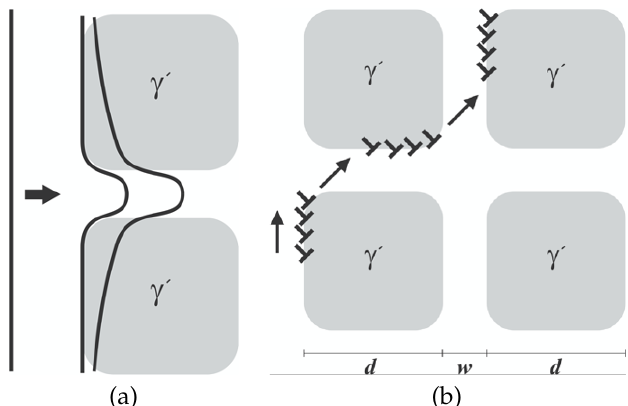
Figure 3. Dominant dislocation mechanisms in nickel-based superalloys: ( a ) Shearing γ (cid:48) and ( b ) Climb and